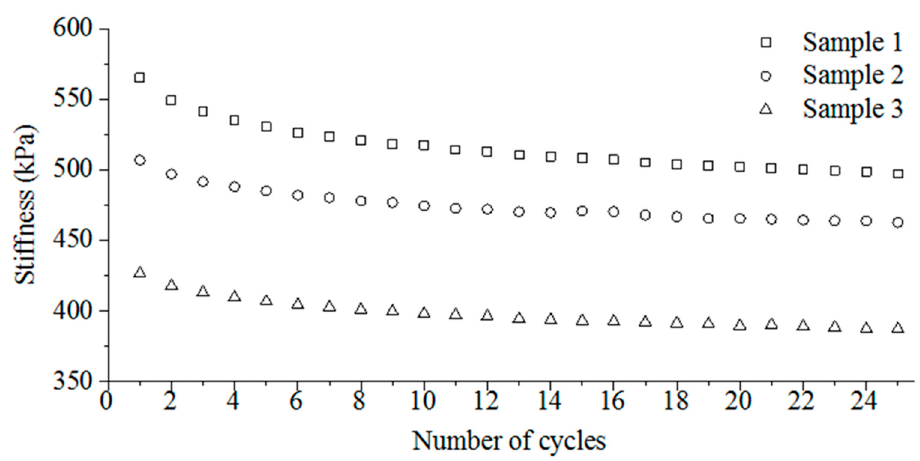
Figure 7. The calculated stiffness as a function of the loading cycles in the case of the N-BCNT/PU- silicone rubber nanocomposites.